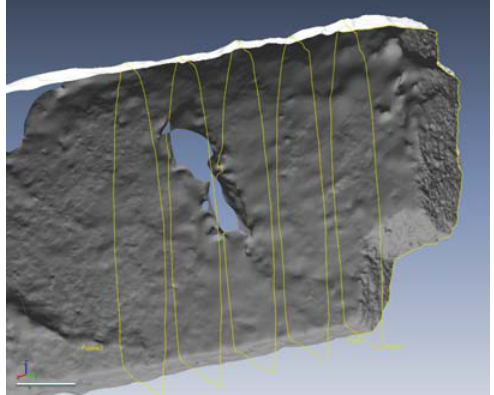
Figure 6. Mine gallery with extracted cross sections and